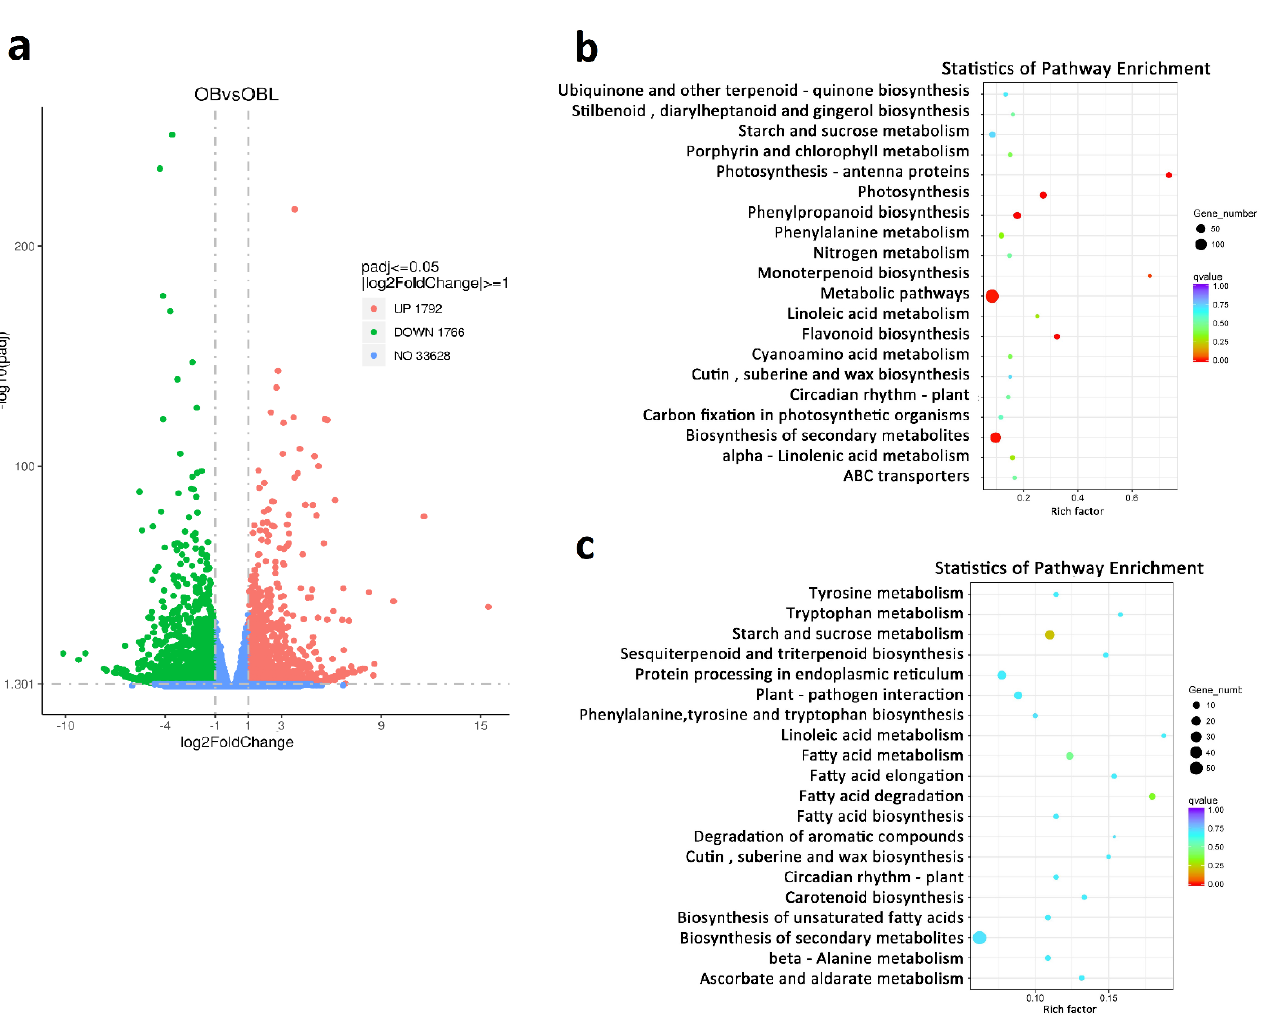
Figure 2. The RNA-seq analysis of stage–5 petals between OB and OBL. ( a ) The volcano map of upregulated (red) and downregulated (green) DEGs between OB vs. OBL. ( b , c ) Statistics of KEGG pathway enrichment for upregulated DEGs and downregulated DEGs.